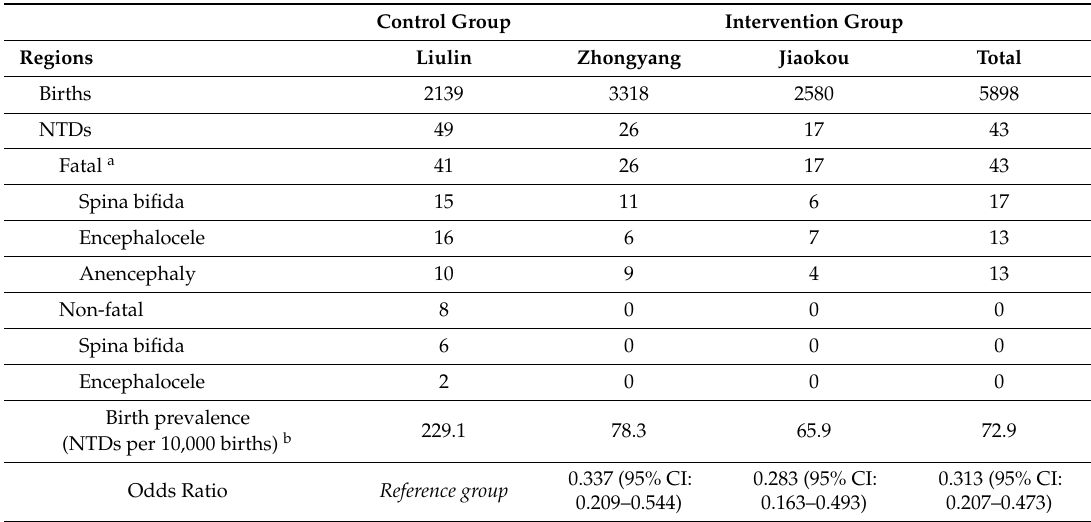
Table 4. Effectiveness of the fortified flour intervention (24 months) at